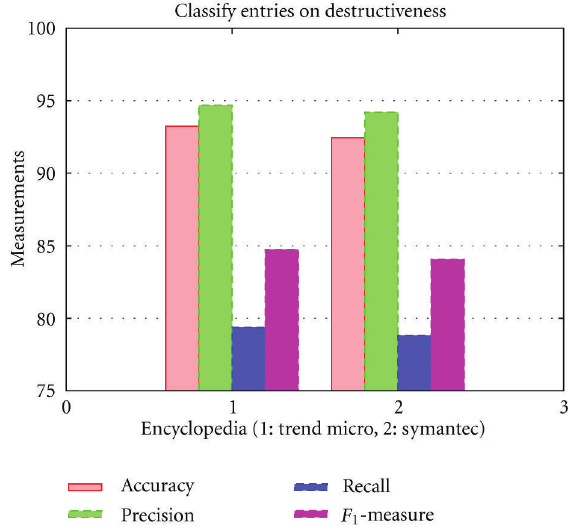
Figure 14: Using learner from Trend Micro to classify entries in Symantec on